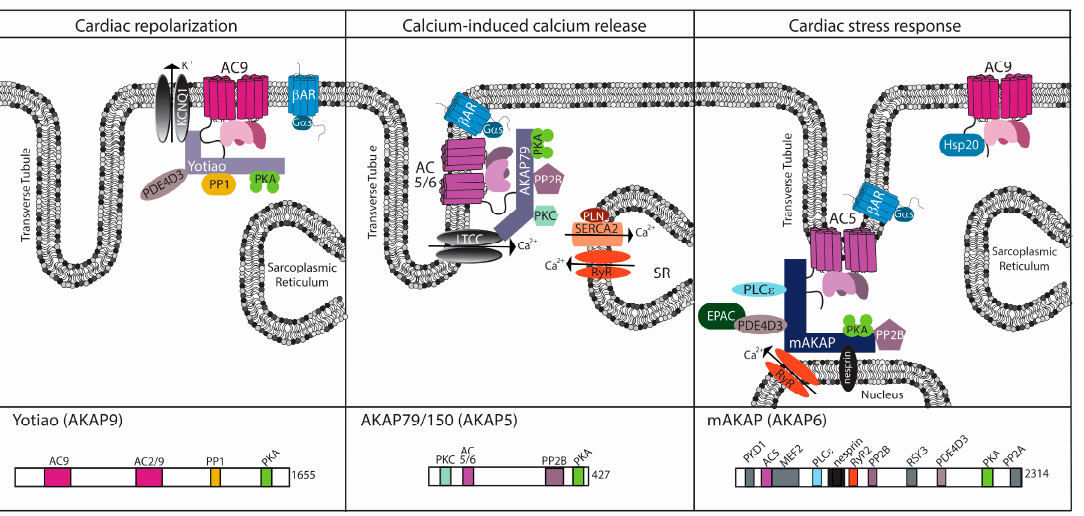
Figure 2. Cardiac AC complexes. AC-associated A-kinase anchoring protein (AKAP) complexes localize to distinct locations within the cardiomyocyte to facilitate physiological function. For each AKAP, a subset of known binding partners and their interaction sites are represented. The model is based upon functional localization of the AC complexes .